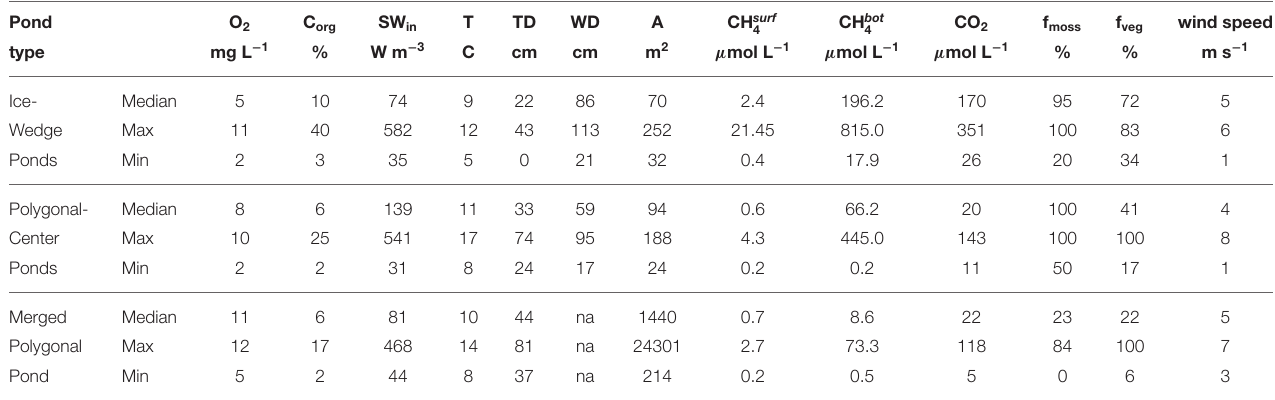
TABLE 1 | Environmental conditions and geomorphological properties of the three pond types during the measurement campaign: dissolved oxygen (O 2 ), organic content in subaquatic topsoil (C org ), mean incoming shortwave radiation in the last 6 h before water sampling (SW in ), surface water temperature (T), thaw depth beneath the pond (TD), water depth (WD), area (A), bottom methane concentration (CH bot 4 ), surface carbon dioxide concentration (CO 2 ), moss-covered fraction of the pond surface (f moss ) fraction of pond overgrown by vascular plants (fveg) and the mean wind speed in the last 1.5 h before water sampling (wind speed).